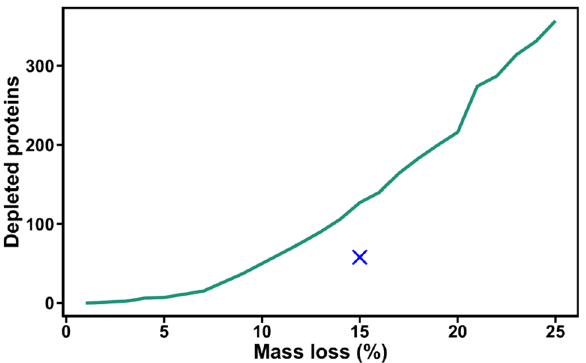
Figure 12. Calculated number of depleted proteins as a function of the mass loss. The result of the Monte Carlo simulations is represented by the green line. The measured protein loss and the number of depleted proteins identified by proteomic analysis for PP surface is shown by a blue